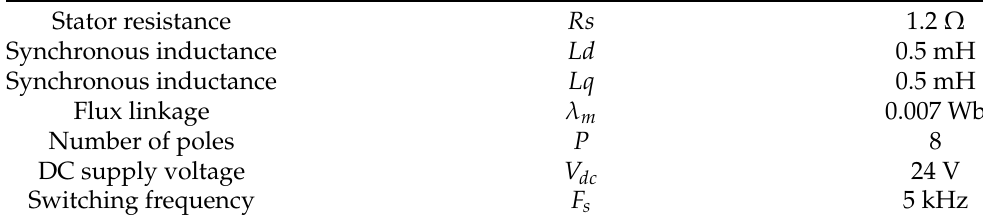
Table 1. Simulation